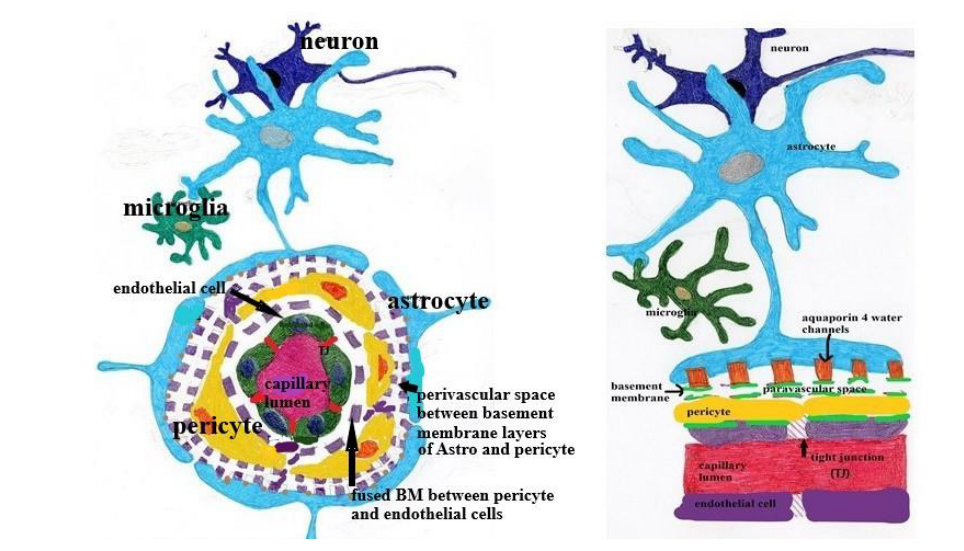
Figure 1. ( A & B ) Normal neurovascular anatomy. Note the tight junctions (TJ) between endothelial cells and the fused two-layer basement membrane (BM) separating them from surrounding pericytes. The BM separates into two layers between the pericytes and astrocyte foot processes forming the perivascular space. Aquaporin 4 water channels expressed in the astrocyte foot process allow bidirectional water flow within the astrocytes and the paravascular space. Egress of paravascular fluid along paravenous channels carries with it actively transported waste from the interstitium ultimately into the meningeal lymphatics.